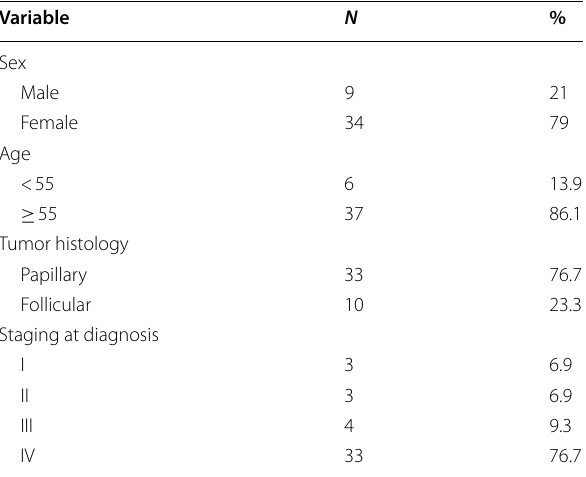
Table 1 Clinico-pathological data of the studied group